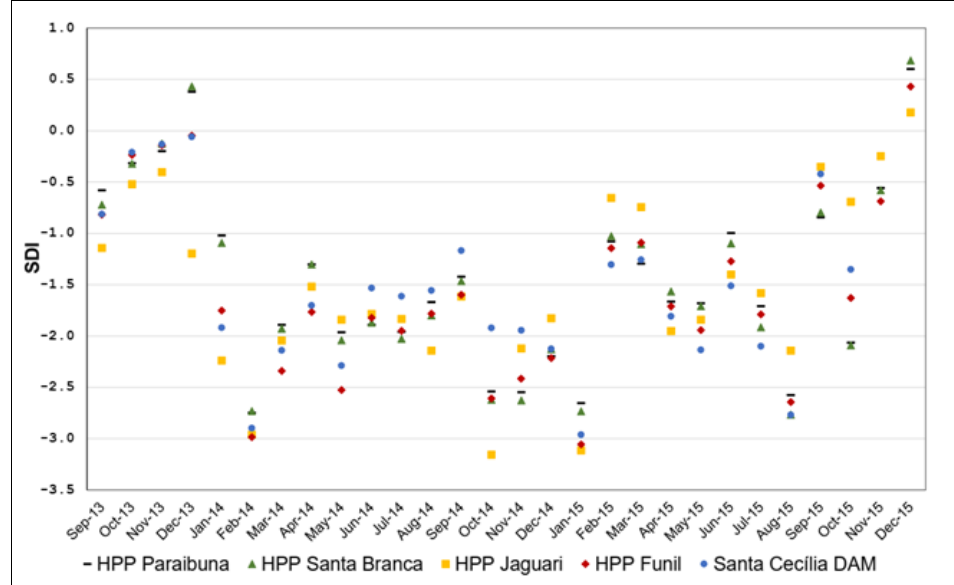
Figure 9. Monthly SDI in the basin’s reservoirs and Santa Cecília Dam.